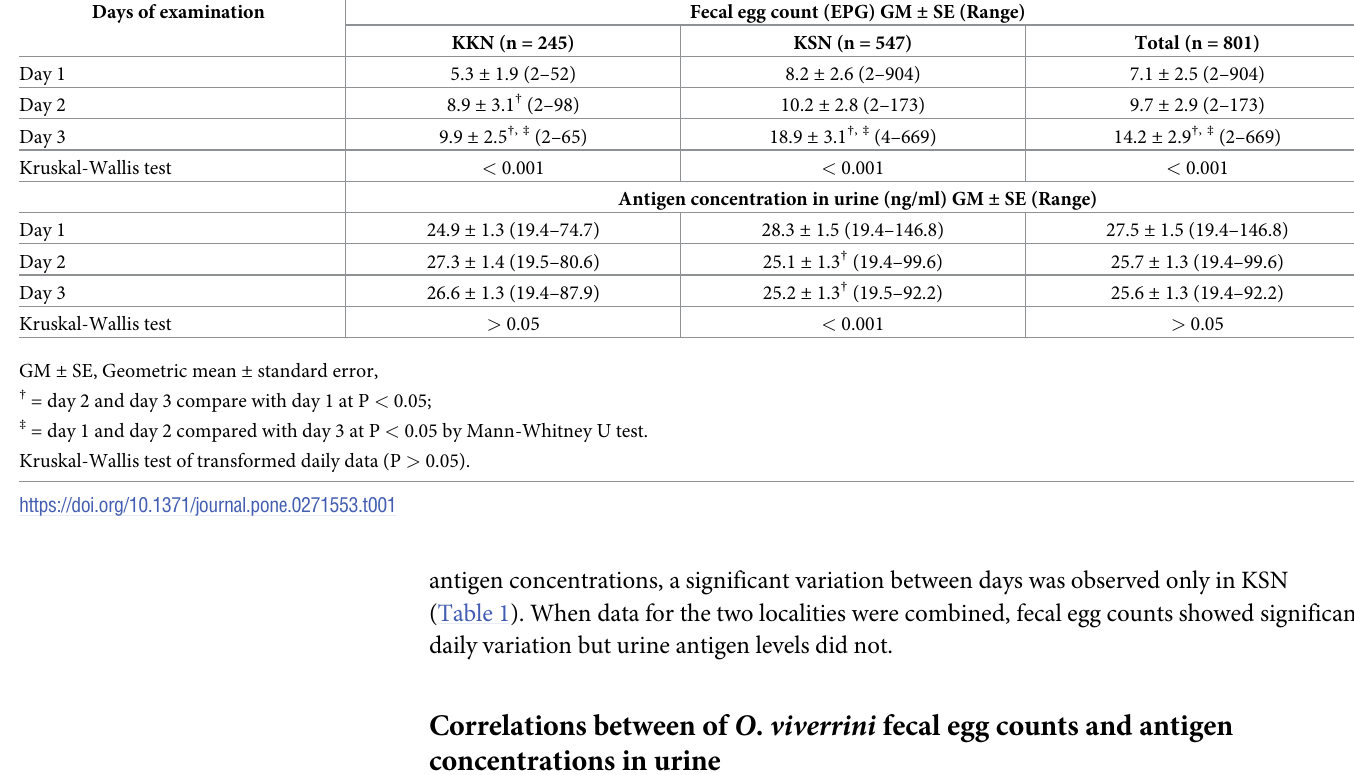
Table 1. Daily variations in intensity of infection measured by fecal egg counts and antigen concentration in urine in Muang District, Khon Kaen Province (KKN), Nong Kung Sri District, Kalasin Province (KSN) in Northeast Thailand. Data shown are geometric means of EPG and antigen concentrations (ng/ml) in urine. Days of